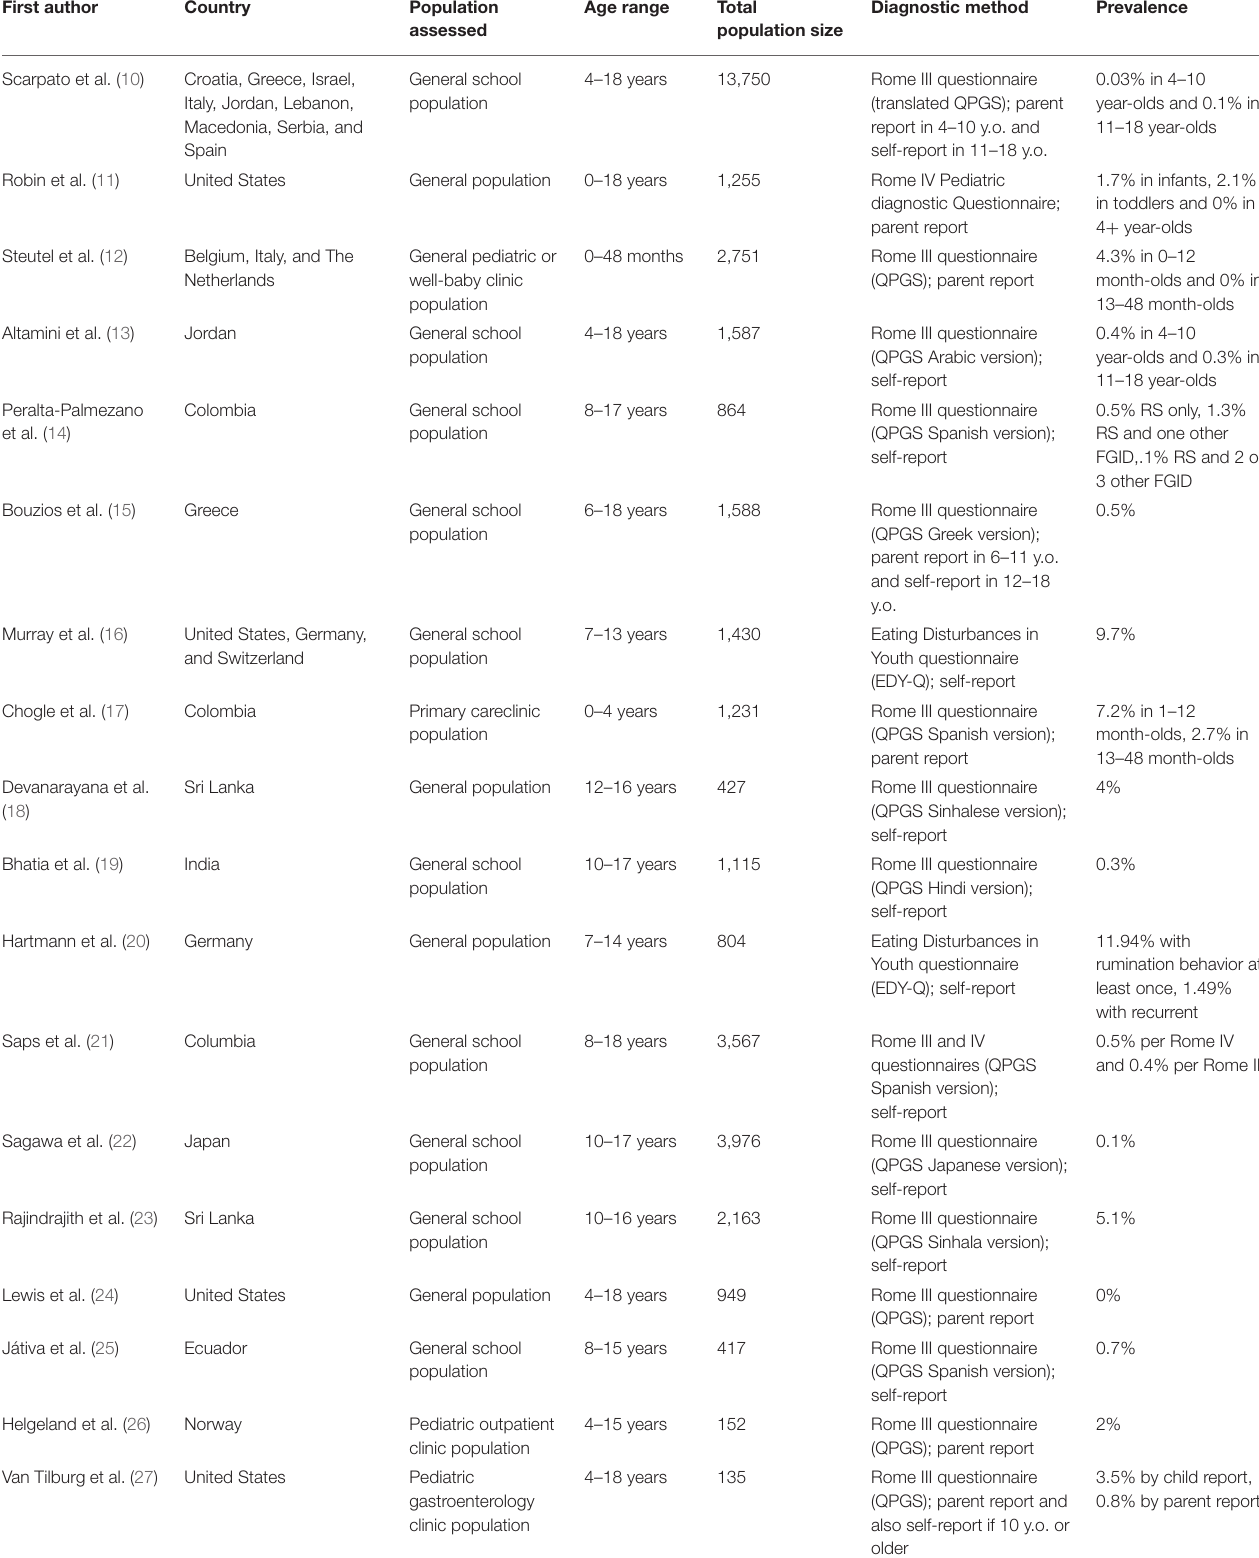
TABLE 1 | Summary of studies reporting prevalence in pediatric rumination